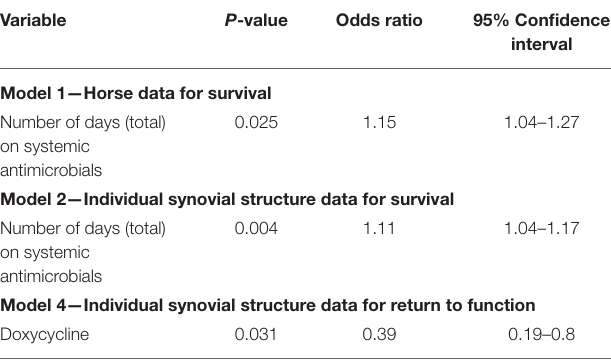
repeated treatments with intra-thecal and regional antimicrobials (OR 0.57, 95% CI 0.41–0.8, P = 0.027) were